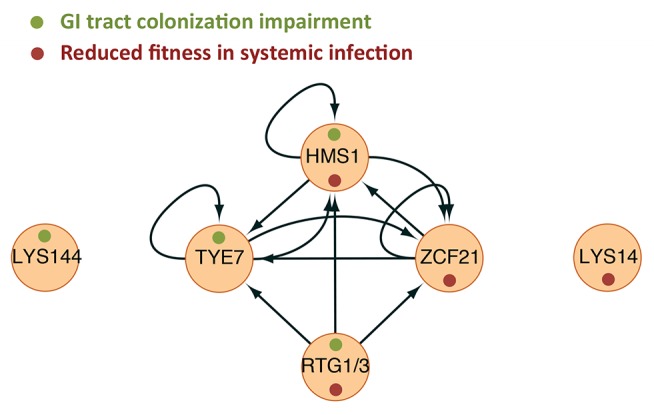
Interplay among C. albicans transcription regulators controlling proliferation in the host.The ChIP-chip–based interactions among the identified TRs are shown. Arrows indicate direct binding events. Green and red dots depict the phenotype associated with each TR.